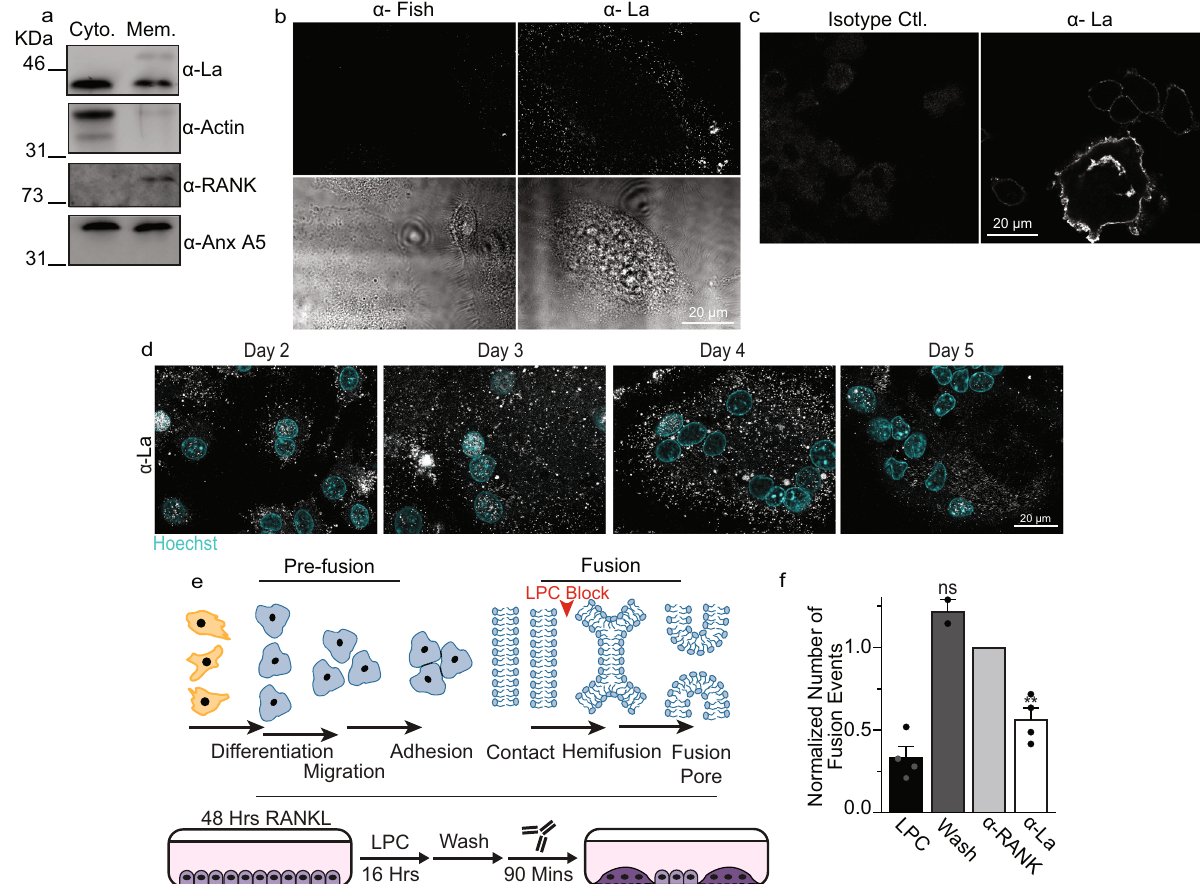
Fig. 3 | La associates with membranes, traf fi cs to the surface and controls osteoclast membrane fusion. a Westerns of cytosolic vs membrane associated protein fractions from human osteoclasts. b Representative immuno fl uorescence images comparing surface staining with α -Fish/TKS5 antibody or α -La mAb in human osteoclasts under non-permeabilized conditions (top) and DIC (bottom). c Representative immuno fl uorescence images comparing surface staining of iso- type control or α -La mAb in RAW 264.7 derived osteoclasts under non- permeabilized conditions. ( α -La mAb). d Representative immuno fl uorescence images of cell surface La in forming human osteoclasts 2 – 5 days post RANKL application. Cells were stained with α -La mAb at the described timepoints without membrane permeabilization. e Cartoons illustrating the stepwise process of the formation of multinucleated osteoclasts (top), and our approach for isolating